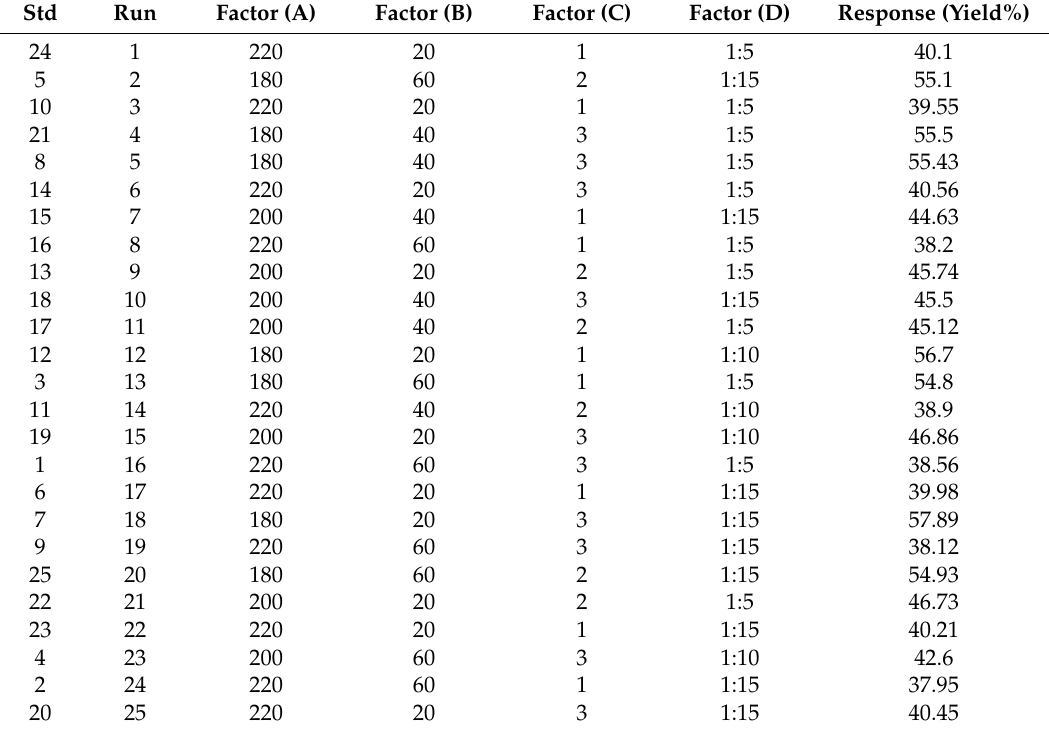
Table 2. The experimental design matrix suggested by the central composite design (CCD) with the corresponding response results of the hydrochar yield (wt